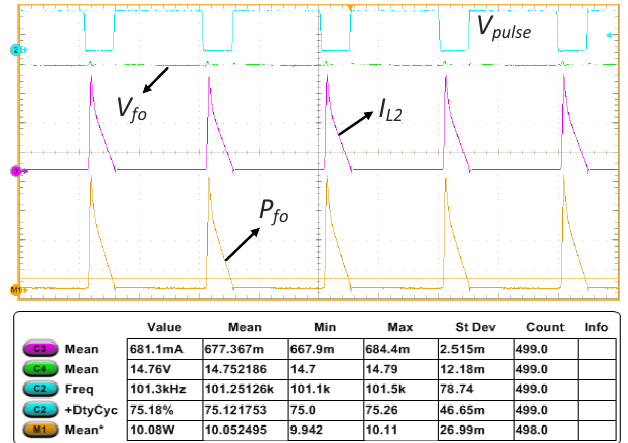
Figure 19. Flyback output power graph.